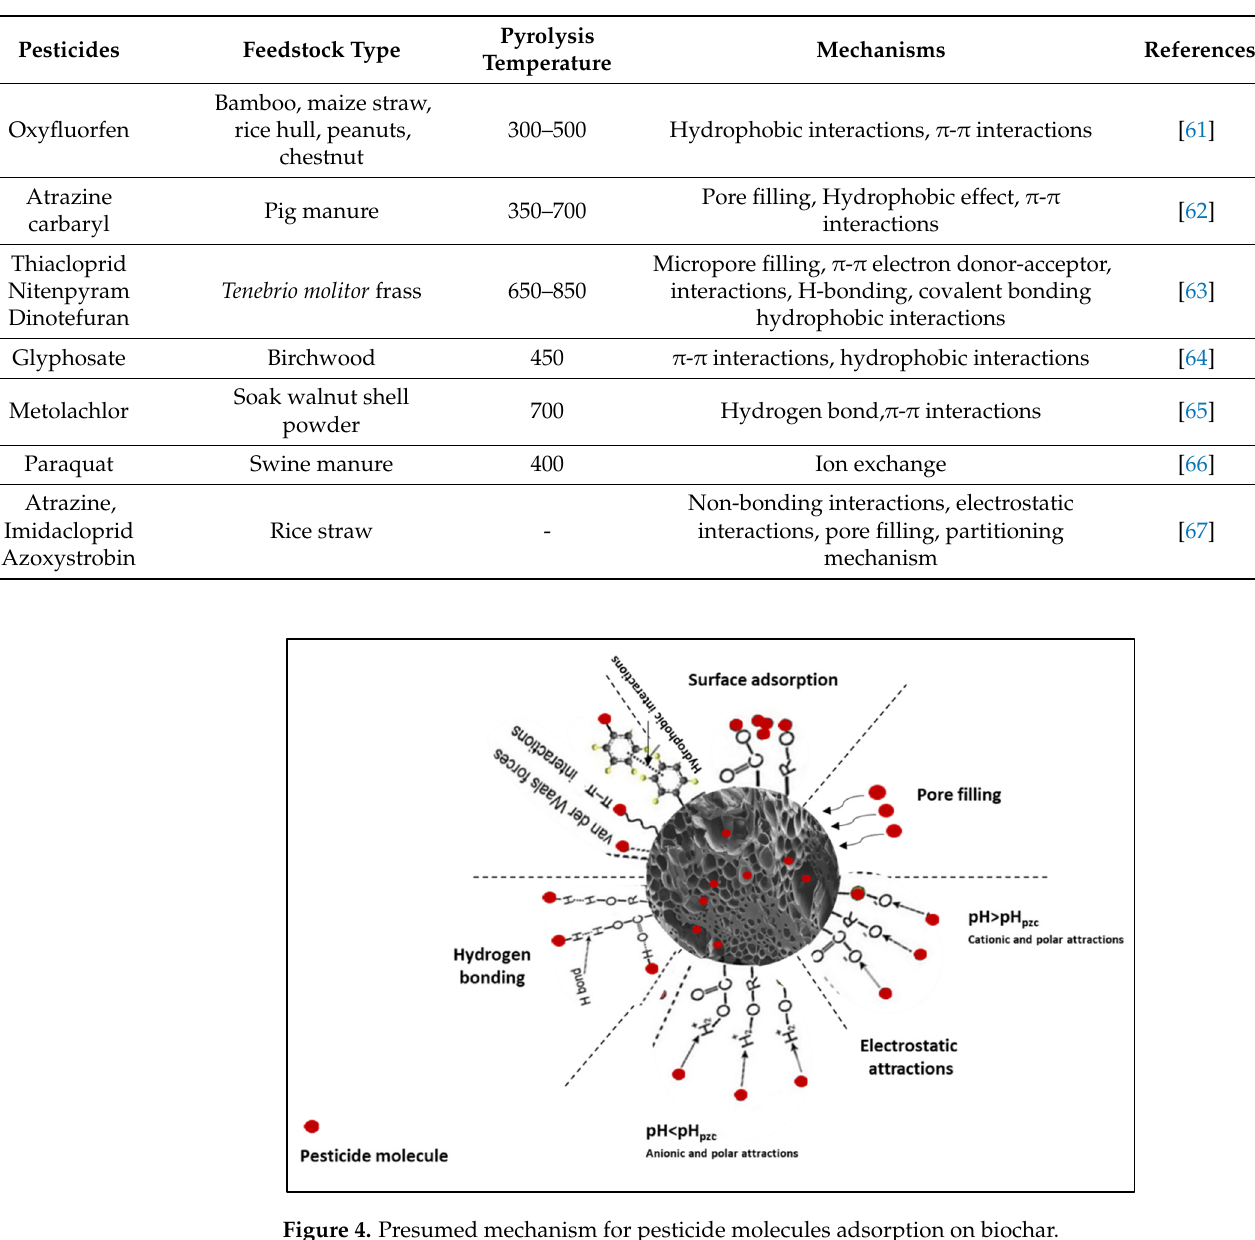
Table 1. Possible adsorption mechanism of pesticides with different biochar types.